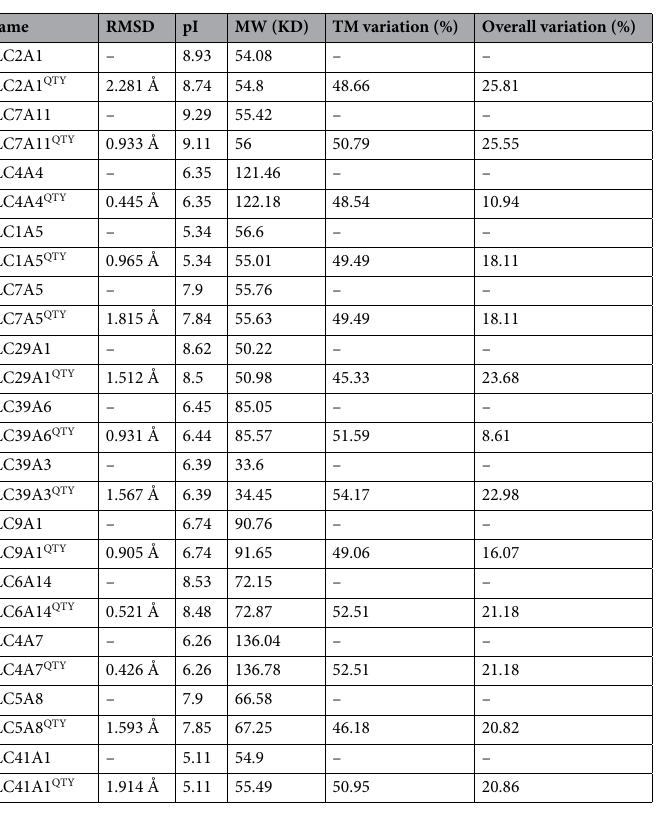
Table 2. Characteristics of native solute carrier transporters and their water-soluble QTY variants. Residue mean-square distance (RMSD) in Å, Isoelectric focusing (pI), Molecular weight (MW), Transmembrane (TM), – = not applicable. The internal and external loops have no changes, the overall changes are not insignificant, and the TM changes are rather